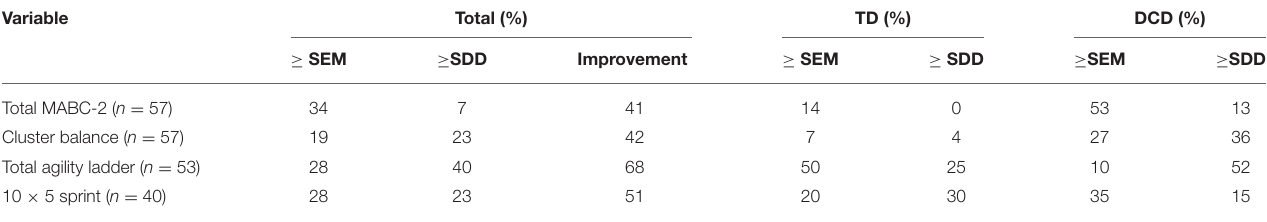
TABLE 6 | Percentage of individuals with progress beyond the SEM and SDD per group.